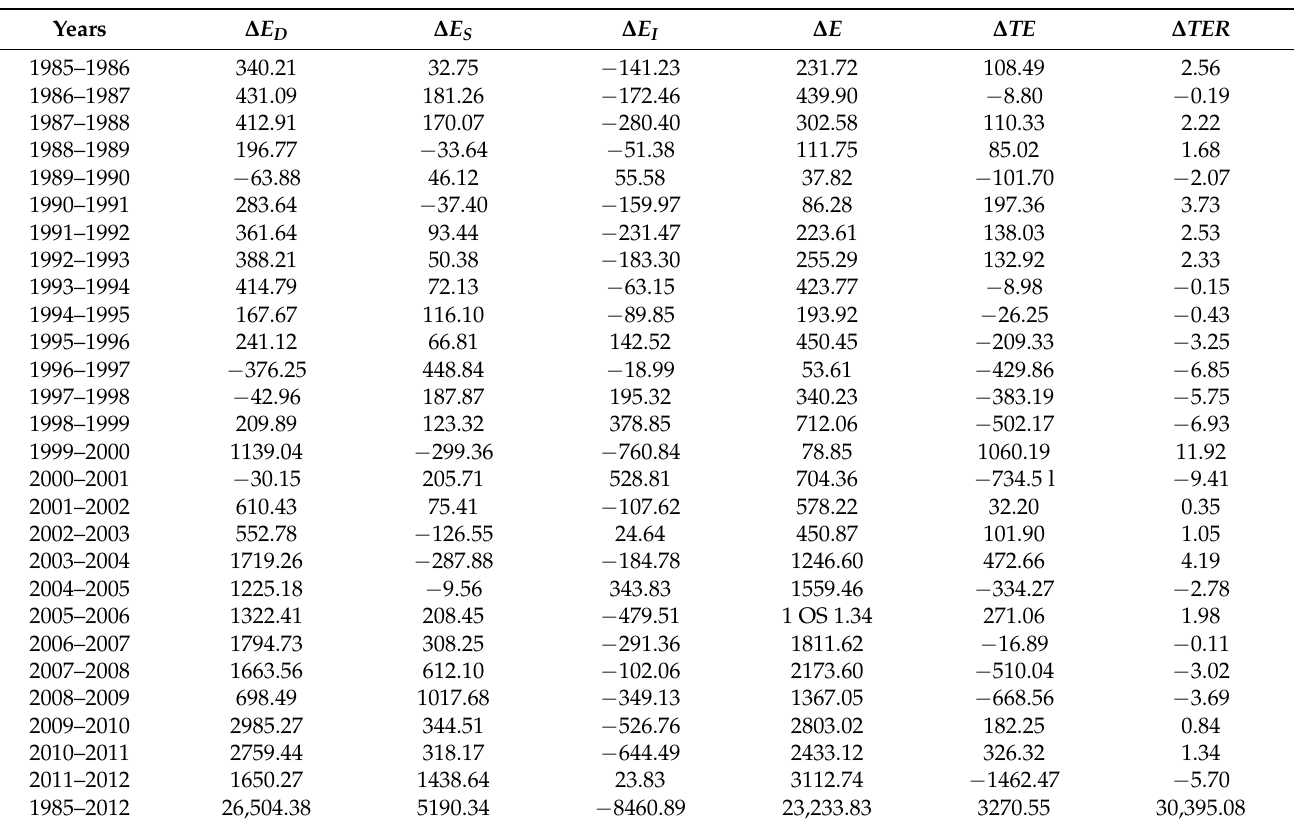
Table 2. The decomposed